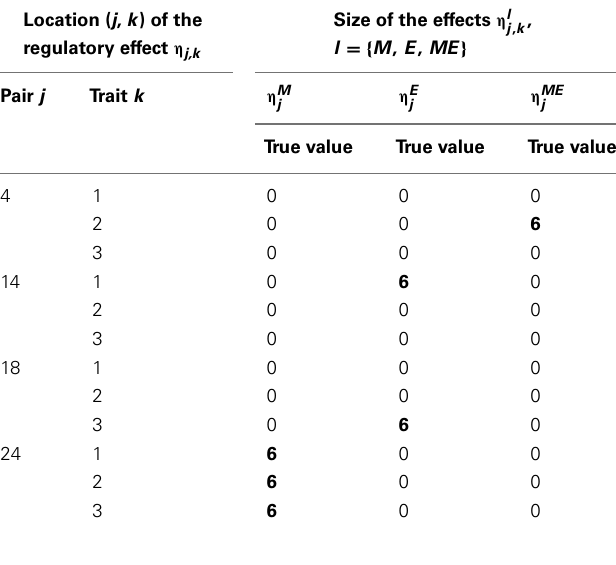
Table 1 | Locations of the non-zero effects: for the first trait, there is marker η M , and expression η E components, for the second trait, 14,1 24,1 marker η M , and a mixed genotype × expression interaction η ME , and 24,2 4,2 for the third trait, marker η M , and expression η E 24,3 18,3